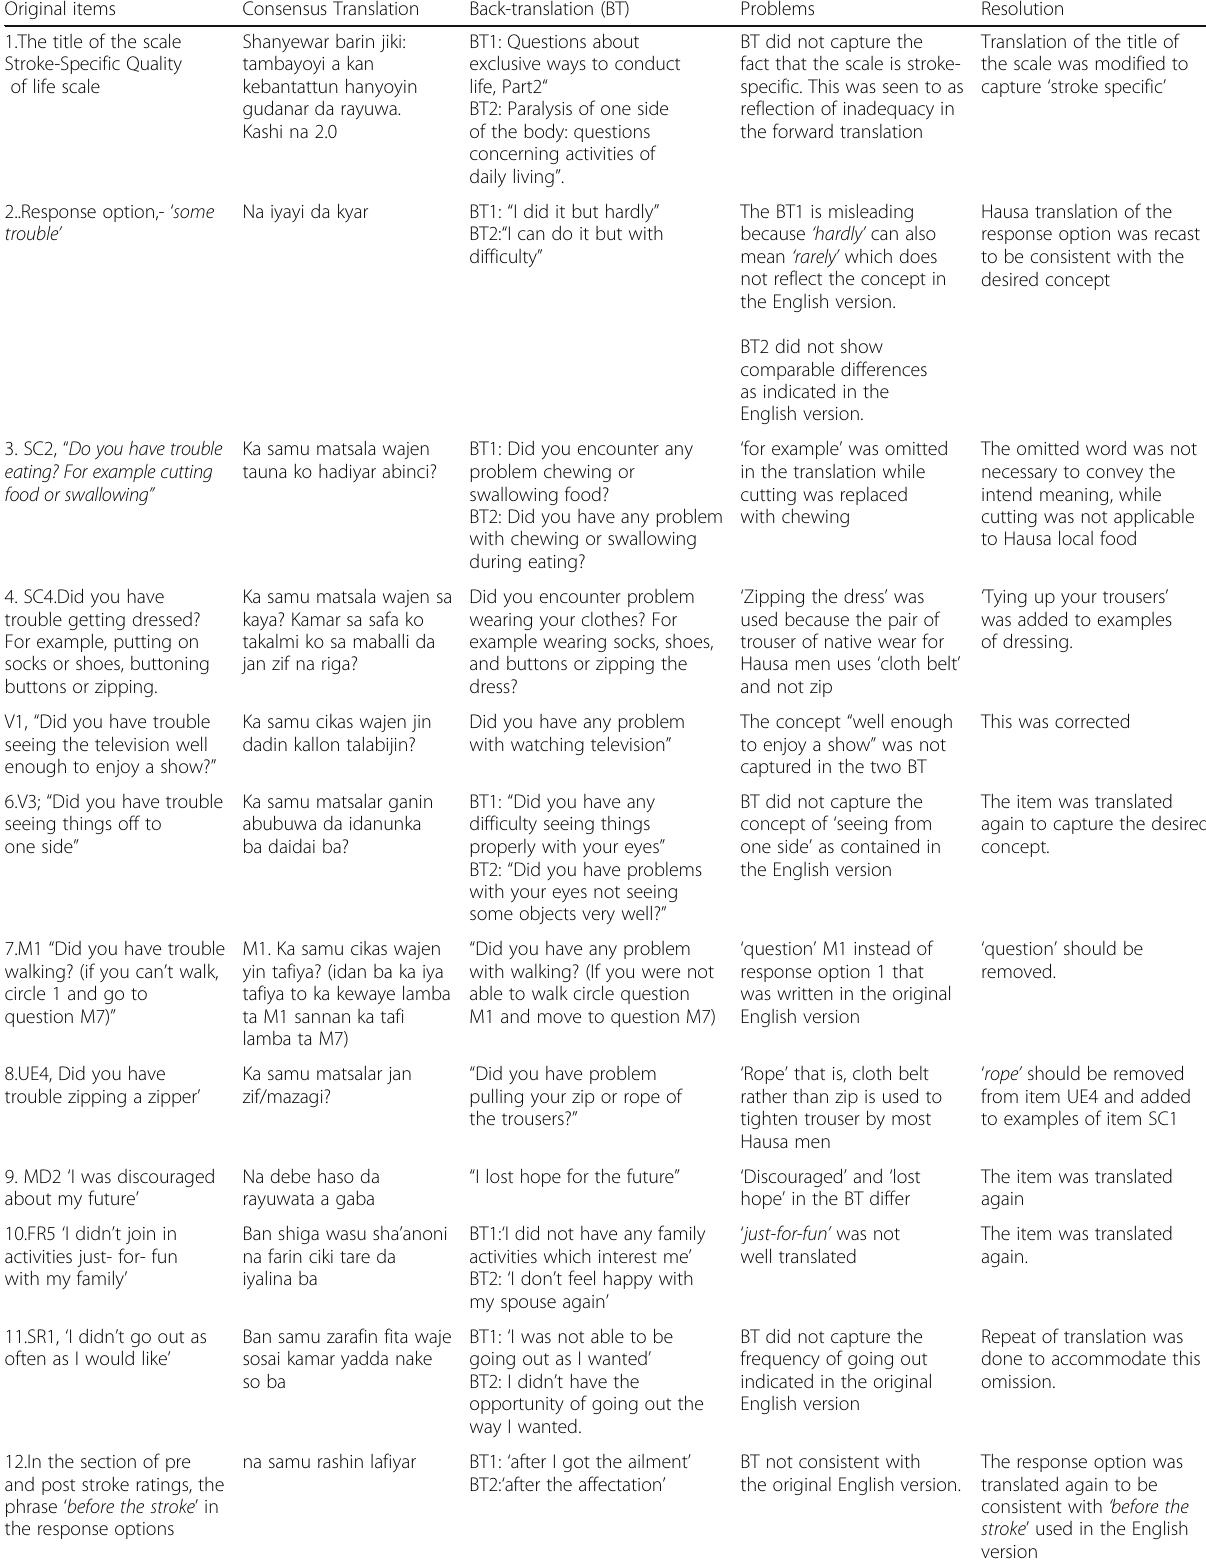
Table 1 Findings from Expert Panel meetings on Hausa version of SS-QoL 2.0